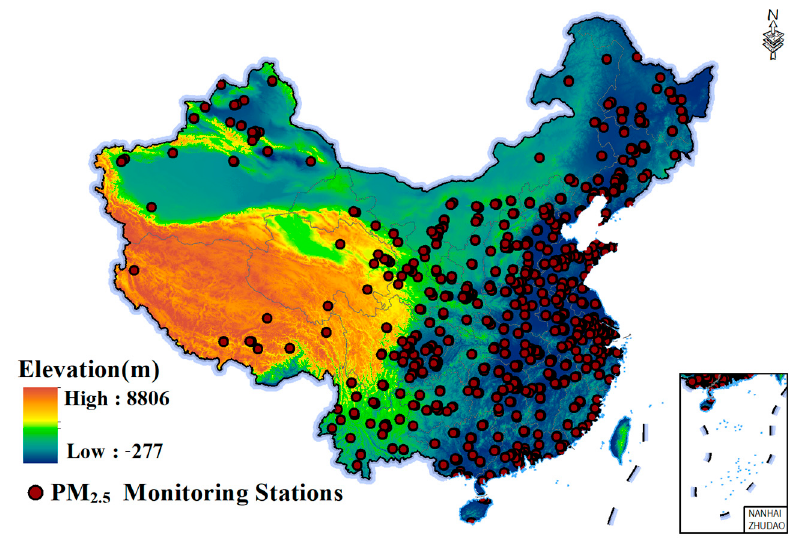
Figure 4. Locations of PM 2.5 monitoring stations in China.